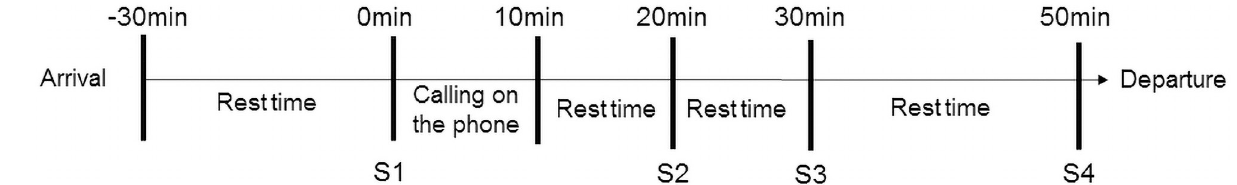
Fig 3. Timeline of events on Days 1 and 2. Both groups of participants ( Hugvie users and only mobile phone users) were requested to relax for 30 minutes before and 40 minutes after talking on the phone. Salivary cortisol measures were collected just before the start of the phone conversation as a baseline measurement (S1), 20 minutes after the start of the conversation (S2), 20 minutes after the end of the conversation (S3), and 40 minutes after the end of the conversation.